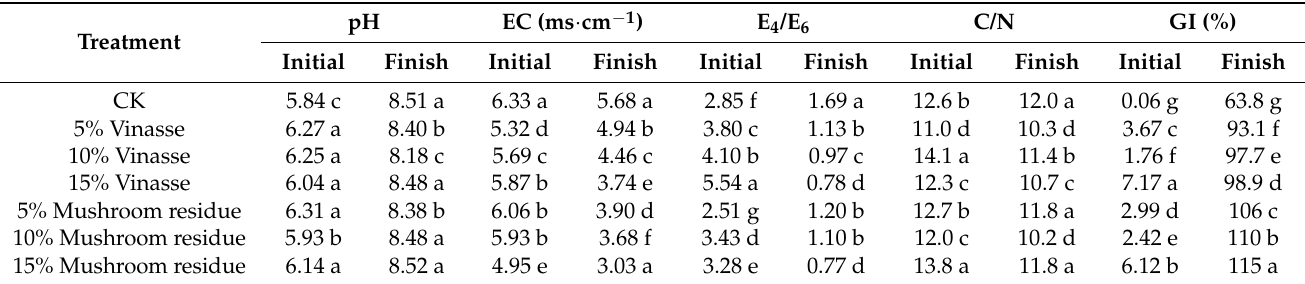
Table 3. Chemical properties and maturity index changes of the compost at the 35th